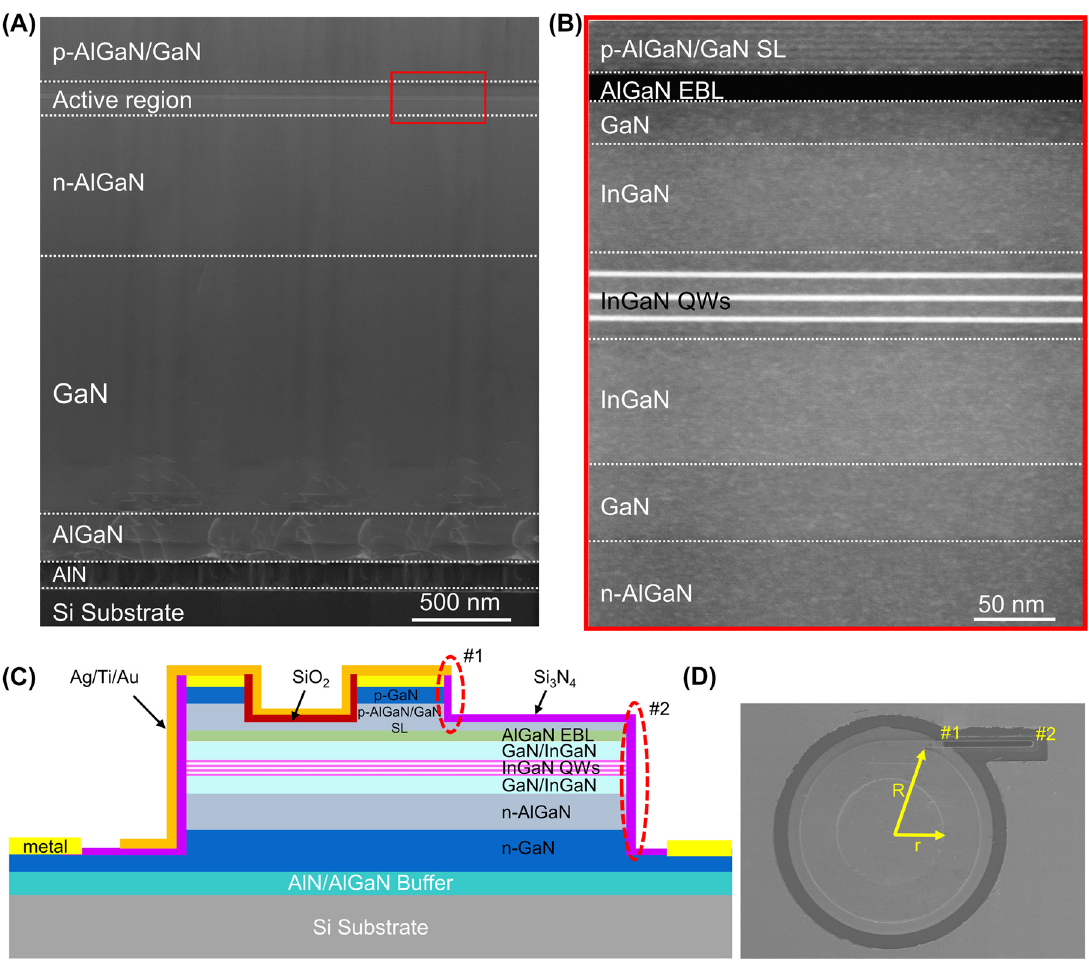
Figure 1: Epitaxial and schematic structures of GaN-on-Si microring lasers. (A) Cross-sectional STEM image of GaN-based microring laser epitaxial structure grown on Si (111) substrate. (B) Enlarged image of the marked red rectangle in (A). (C) Cross-sectional schematic diagram, and (D) top-view SEM image of the as-fabricated GaN-on-Si LD-W-Ag with an outer ( R ) and inner ( r ) radius of 50 and 30 μ m, respectively. The points #1 and #2 in the figure are two end facets of the waveguide fabricated by